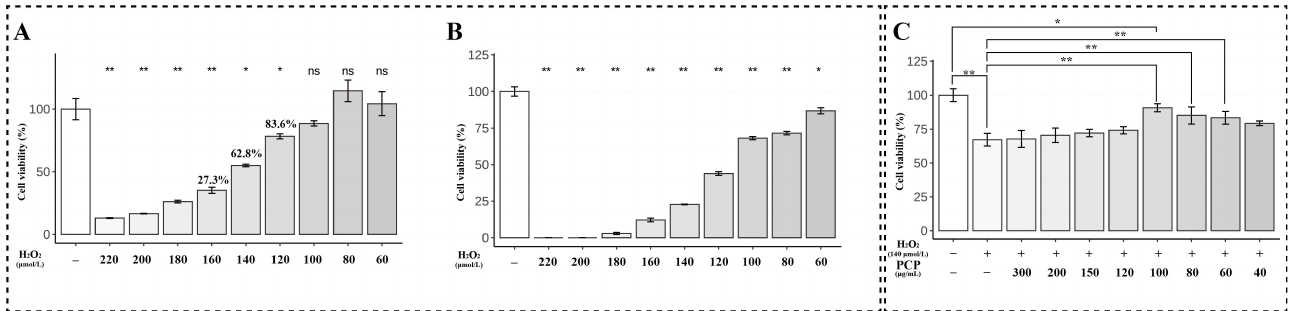
Figure 2. The cell viability in microglia. The cells were treated using H 2 O 2 at different concentrations (0, 40, 60, 80, 100, 120, 140, 160, 180, and 200 µ mol) for 24 h and 48 h. Then being treated with H 2 O 2 and PCP using different concentrations (0, 40, 60, 80, 100, 120, 150, 200, and 300 µ g/mL) was measured with the CCK8 assay. The cell viability of the microglia after H 2 O 2 treatment for 24 h ( A ), 48 h ( B ), and the cell viability of microglia after utilizing H 2 O 2 + PCP treatment ( C ). ( ns p > 0.05, * p < 0.05 and ** p <